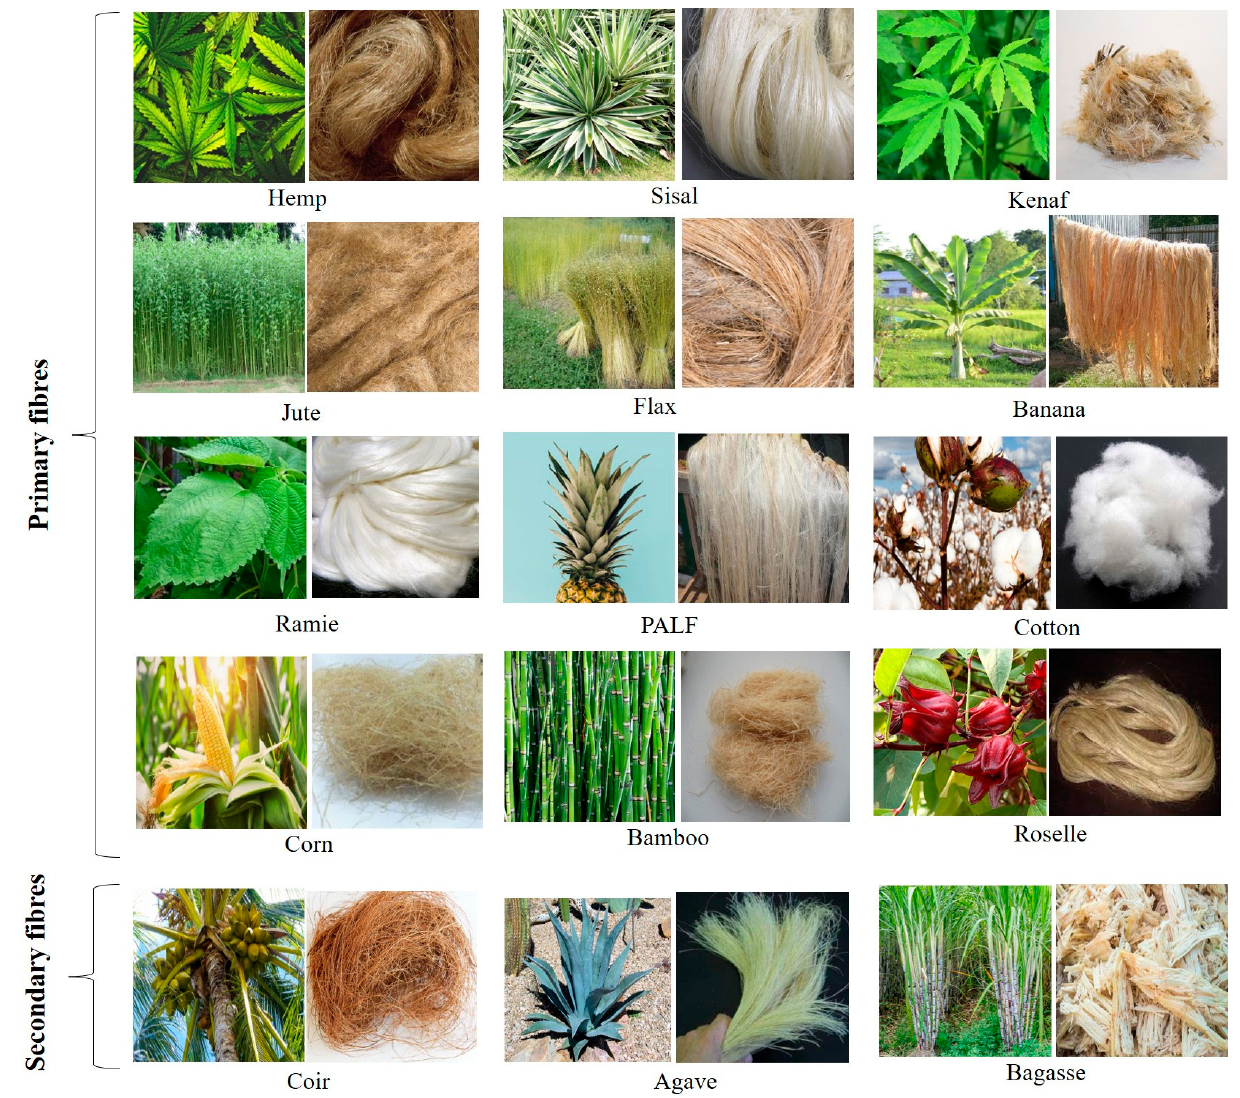
Figure 2. Commonly available natural plant fibres and their sources [32–60] Agave fiber figure Reprinted with permission from Ref. [58].Copyright 2021 Elsevier Ltd.